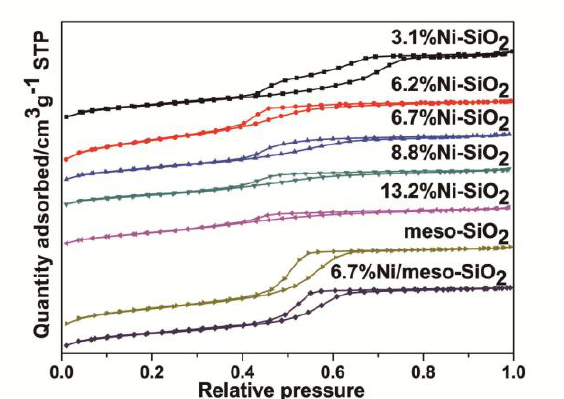
Figure 3. N adsorption-desorption isotherms of the meso-SiO 2 Ni-SiO 2